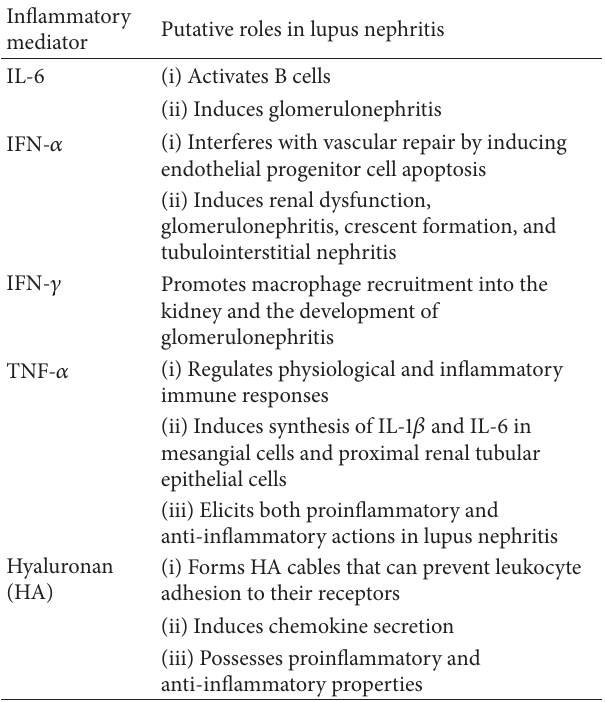
Table 1: Mediators of inflammation that play important roles in the pathogenesis of lupus